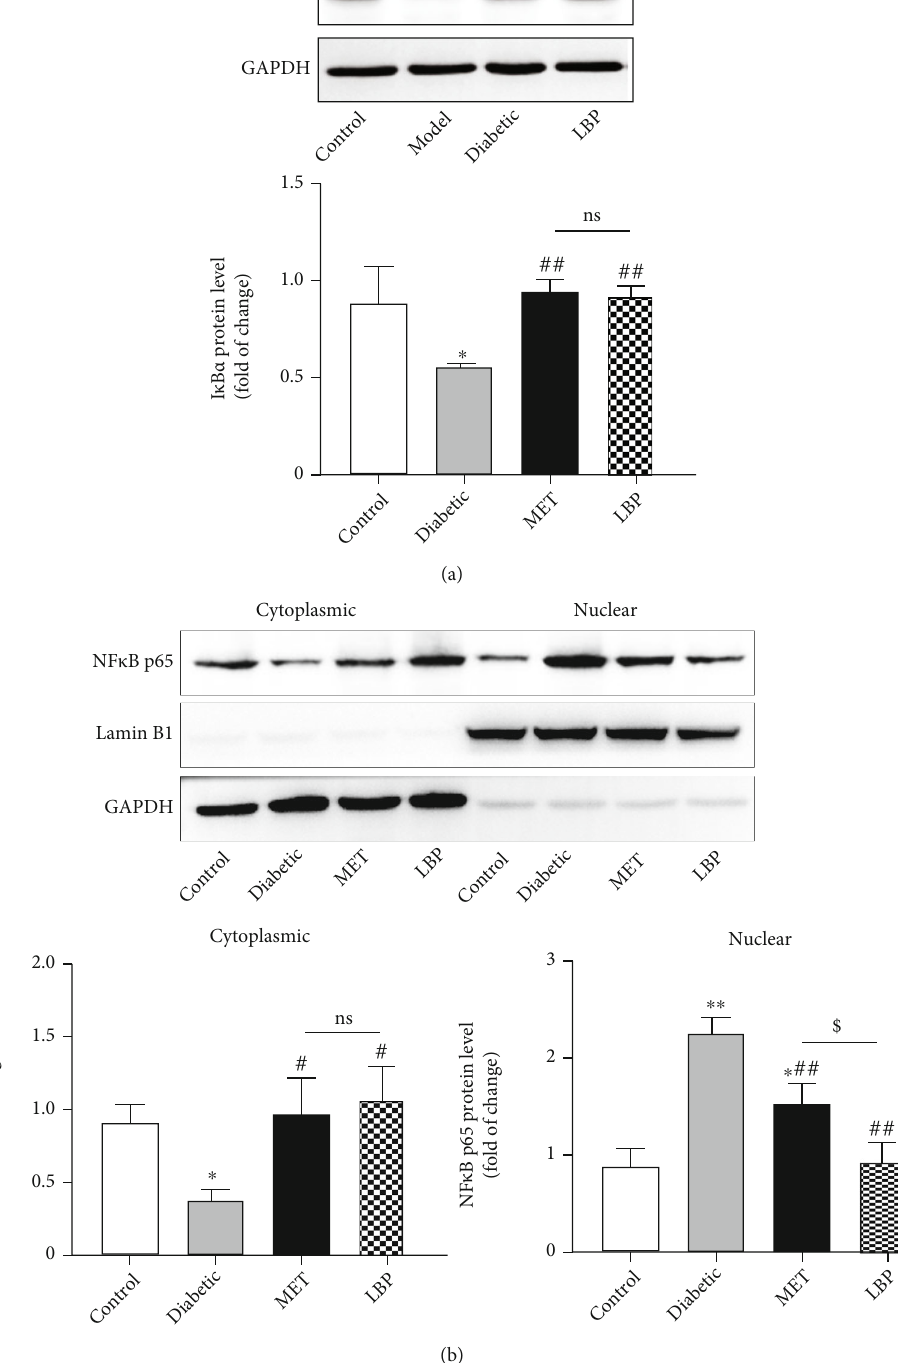
Figure 5: LBP inhibited NF- κ B signaling pathway in DN mice. (a) The protein level of I κ B α in the kidney and (b) the translocation of NF- κ B p65. Data are expressed as the mean ± SD ( n = 6 -9 mice per group). ∗ Control vs. other groups, ∗ p < 0 : 05, ∗∗ p < 0 : 01 ; # diabetic vs. other groups, # p < 0 : 05, ## p < 0 : 01 ; $ MET vs. LBP, $ p < 0 : 05, $$ p < 0 : 01 ; ns means no signi fi